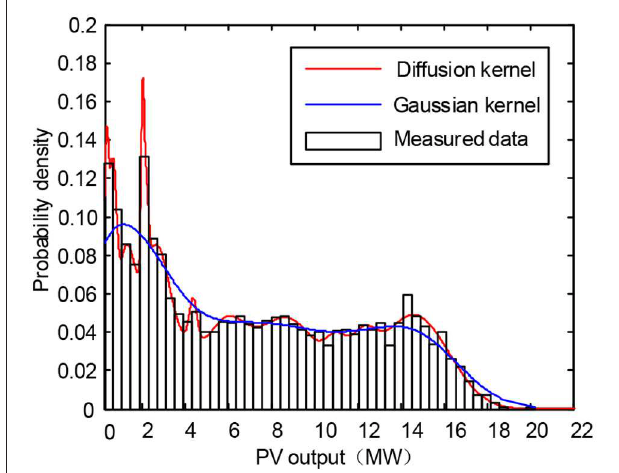
FIGURE 1 | Probability density of photovoltaic (PV)